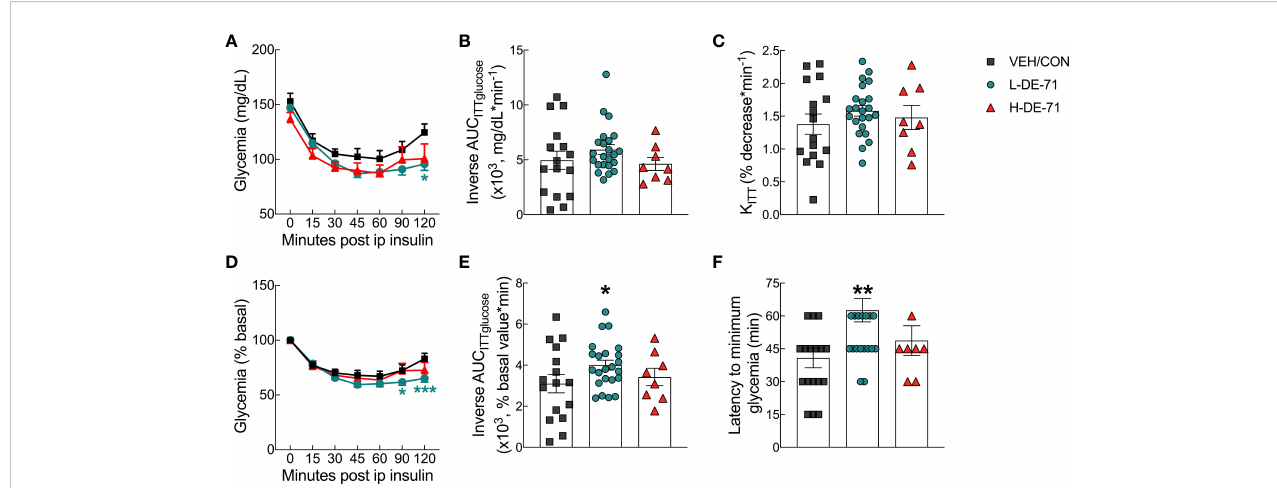
FIGURE 4 Abnormal glycemia reduction after insulin challenge in male mice offspring exposed perinatally to L-DE-71. (A) Absolute blood glucose concentrations were recorded before and at t =15, 30, 45, 60, 90 and 120 min post-injection with 0.25 U/kg insulin. (B) Tolerance to insulin challenge was analyzed by the inverse integrated area under the ITT glucose curve (AUC ITTglucose ). (C) Rate constant for glucose reduction (K ITT ) was calculated over the initial slope of ITT glucose response curve from 0-30 min post-injection. (D) Glucose values taken during ITT are plotted vs time as a percent of the individual baseline. (E) The inverse integrated area (AUC) under the percent basal glucose curve (AUC ITTglucose ). (F) Latency to minimum blood glucose measured over the two-hour time course of ITT glucose response. *indicates signi fi cantly different from VEH/CON (* p <0.05, ** p <0.01, *** p <0.001). All values are expressed as mean ± s.e.m. n ,